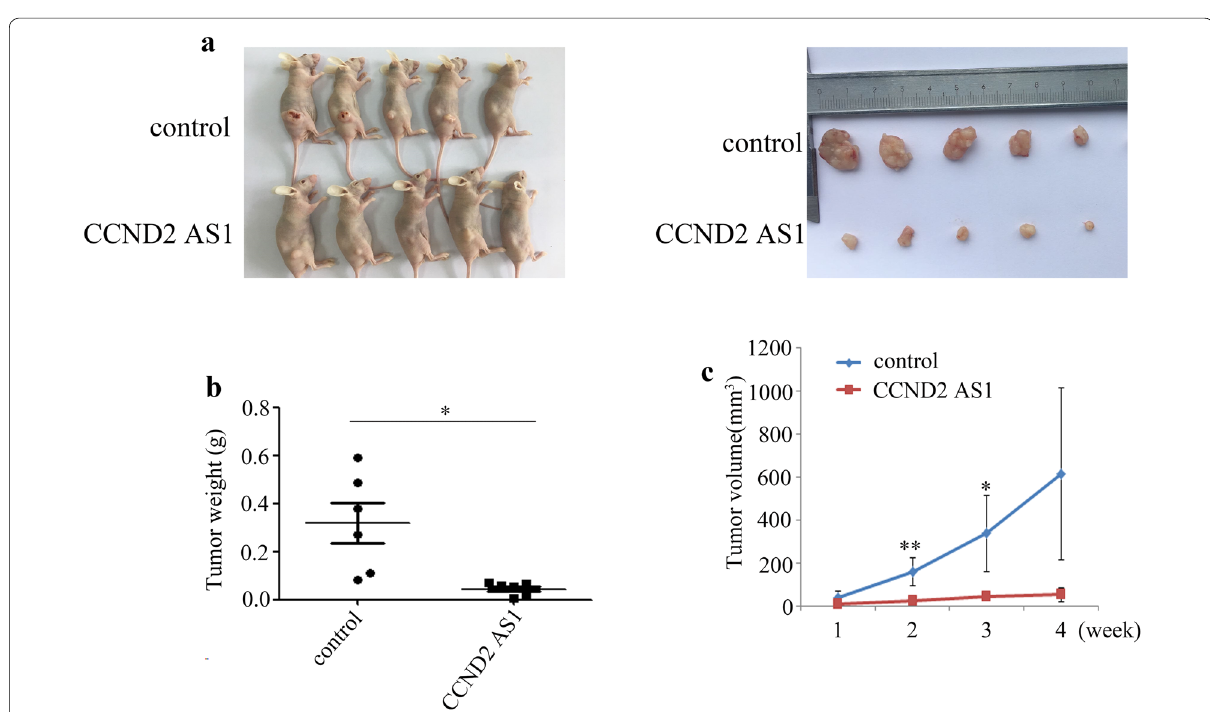
Fig. 5 Elevated expression of CCND2 AS1 suppressed tumor growth in vivo. a Images of tumors formed in the nude mice injected with the indicated cells. The control or HeLa-pCCND2 AS1 were injected into the right flanks (n inhibited tumor growth in tumor weights and sizes in nude mice. Tumor volumes were calculated by the formula: V